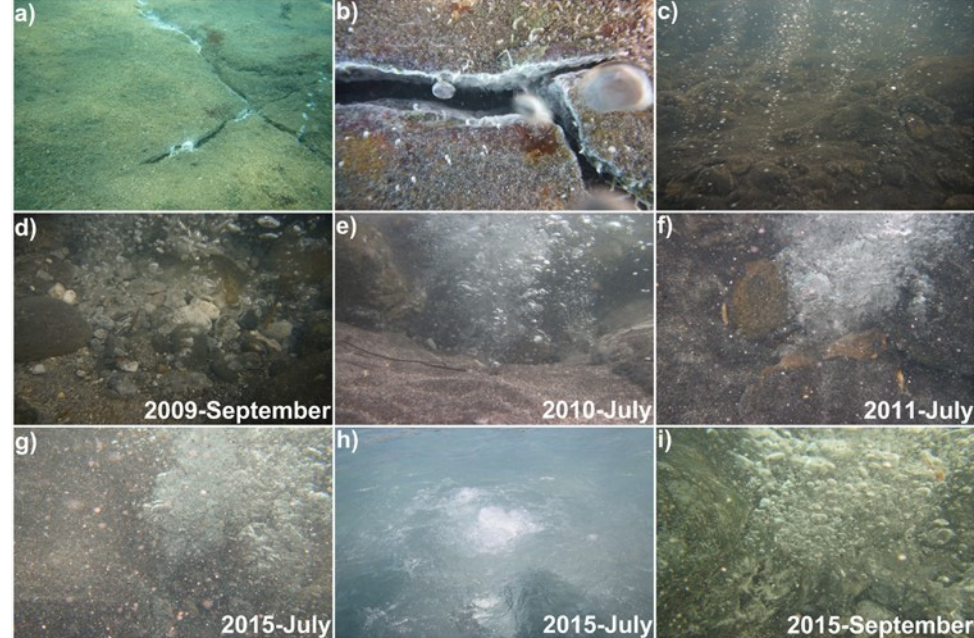
Figure 7. Underwater photos taken in the Baia di Levante, close to the shoreline (water depth 1 m). ( a ) Low degassing from the fracture network in the southern sector of the bay; ( b ) example of a degassing fracture with gas bubbles and whitish sulfur floccules around it; ( c ) degassing from coarse sandy and gravel deposits in the northern sector of the bay; ( d – i ) degassing from the P1 vent in different years. All the photos were taken from the same shot-point, except ( h ) which was taken from the surface.